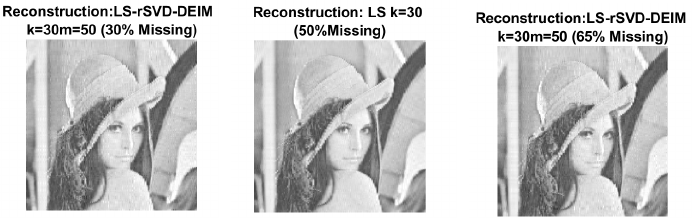
Figure 2. (Numerical Test 1) Reconstructions of incomplete images with 30%, 50%, and 65% missing pixels by the standard POD-LS accelerated POD-LS approach using k = 30 ( Top ) and the proposed POD-LS approach using k = 30 and m = 50 ( Bottom ).